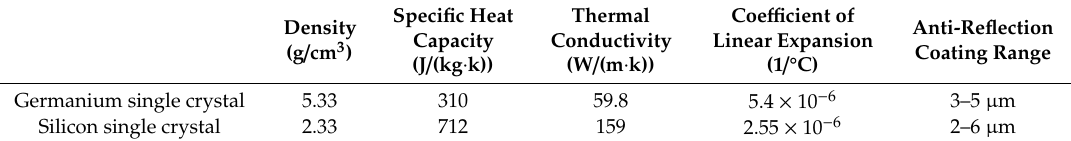
Table 3. Absorption rate of the 1.06 µ m laser by a flat